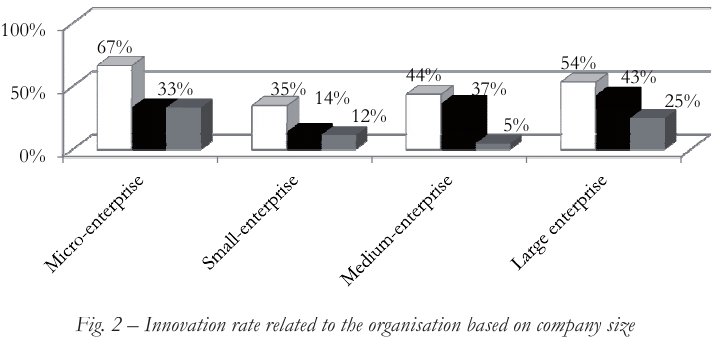
Fig. 2 – Innovation rate related to the organisation based on company size Source: own compilation